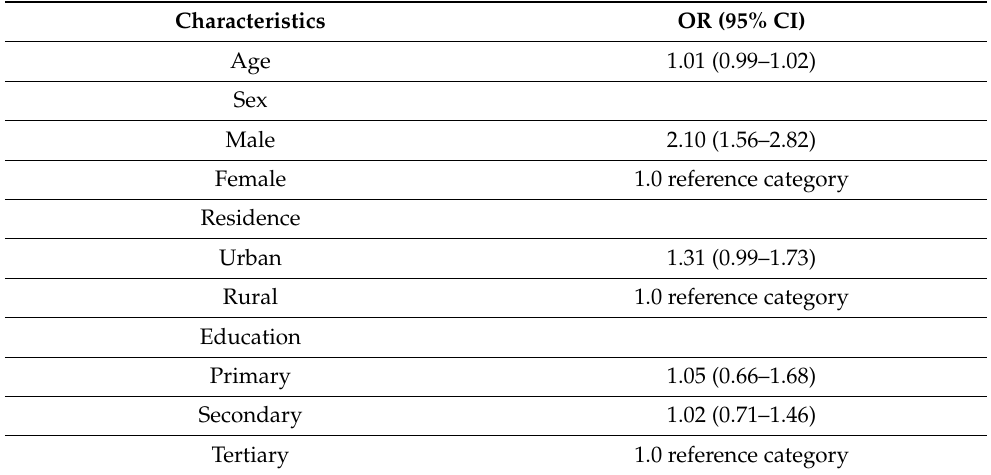
Table 3. Multivariate logistic regression analysis with a moderate risk of psychological distress as an outcome